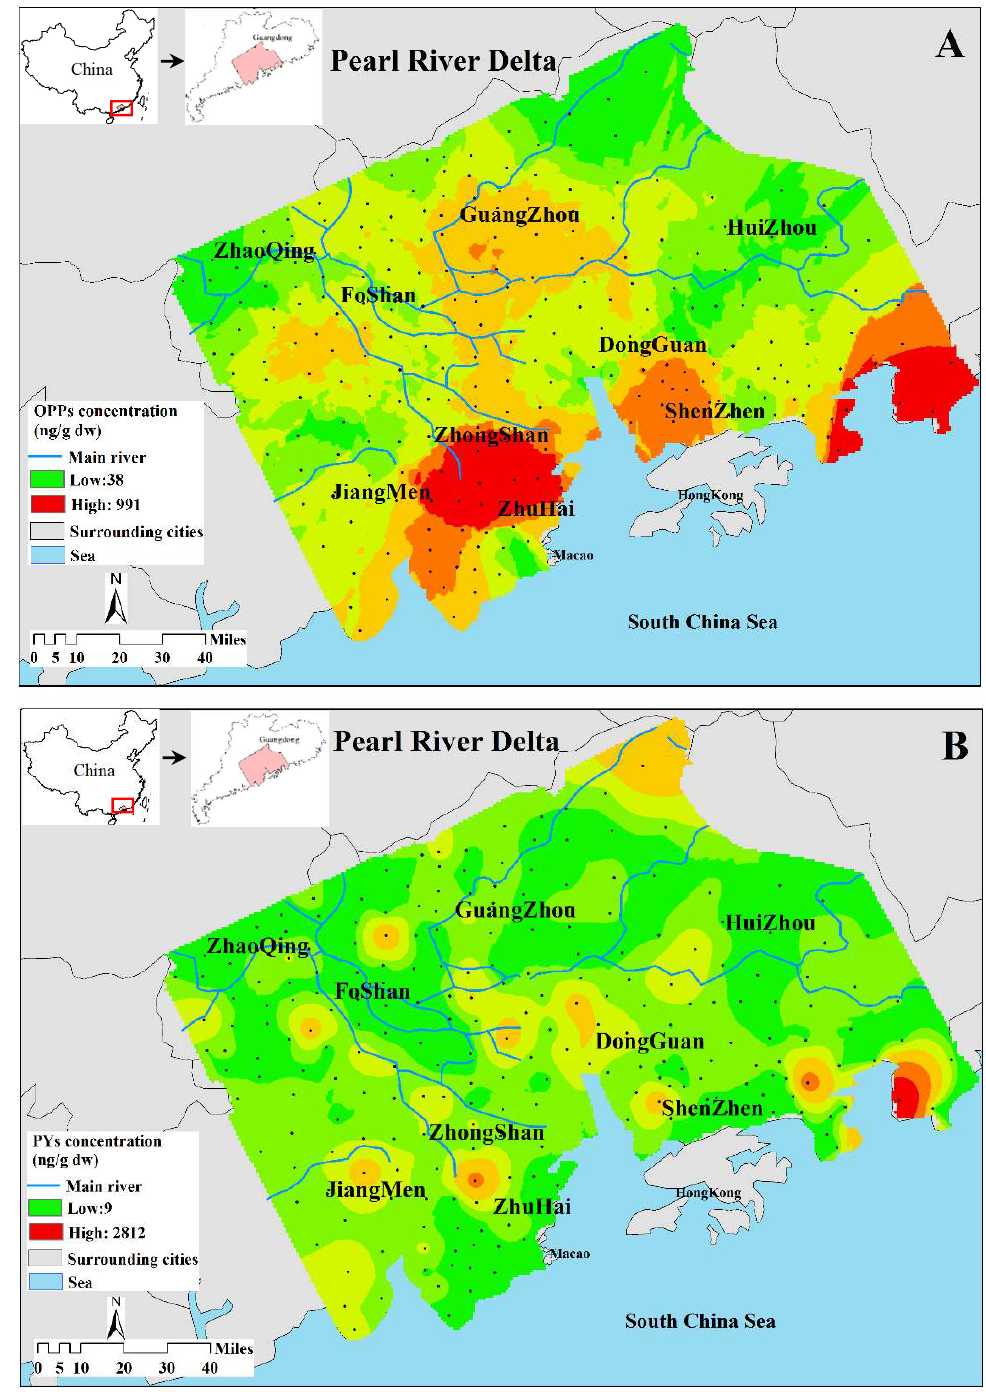
Figure 3. The spatial distributions of OPPs ( A ) and PYs ( B ) in agricultural soils of the PRD region. High residues of OPPs and PYs were both found in the soils closer to the seaside, among which ZH and HZ suffered more serious combined pesticide pollution. However, OPPs and PYs were both found to be at a low level in agricultural soils from ZQ. The humid and warm weather in Guangdong province facilitates the propagation of pests [24].